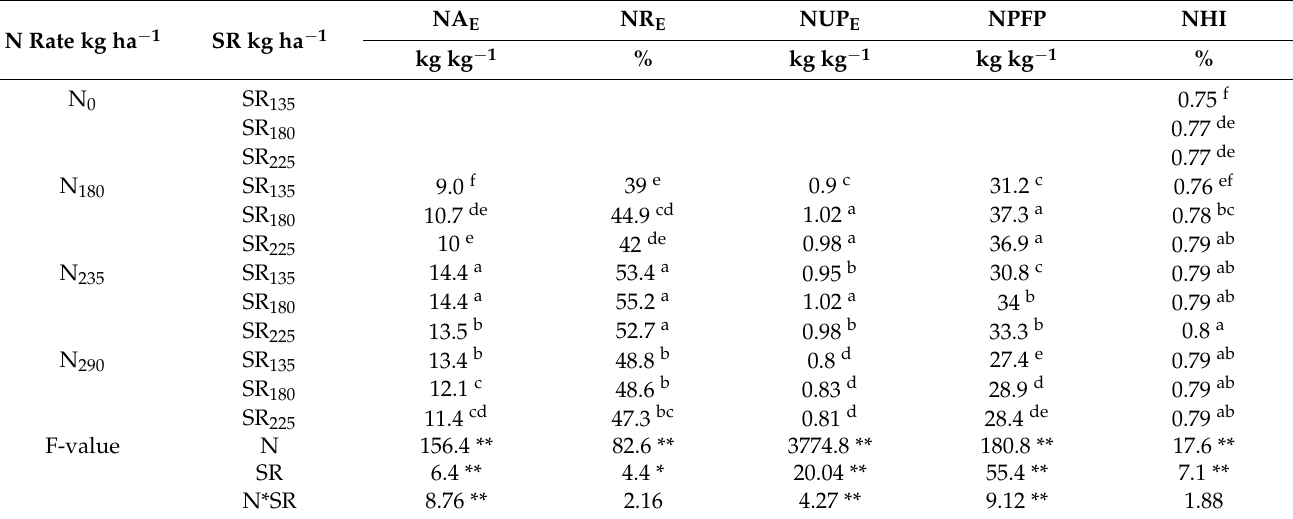
Table 6. Combination effects of N and SR on N use efficiency parameters in